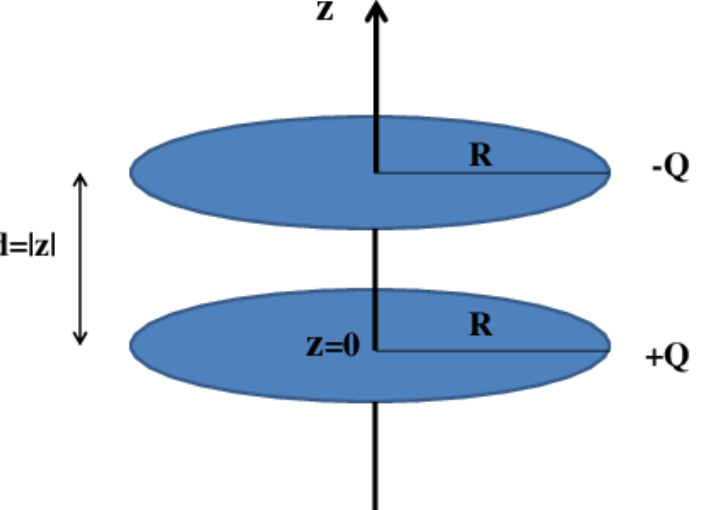
Figure 1. Schematic view of a circular parallel plate nanocapacitor. The two circular plates have a radius R and are at a distance, d = | z | ≥ 0 apart. The respective ± Q charge of each of the circular plates is assumed to be uniformly spread over the corresponding